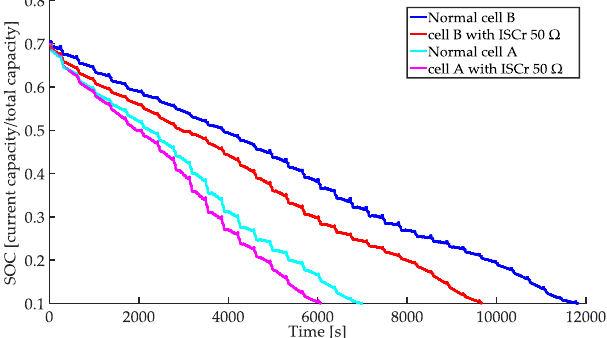
Figure 11. Comparison of estimated SOCs of normal cells and of cells with ISCr 50 Ω (experiments: DST 5 A for cell A and DST 3 A for cell B).